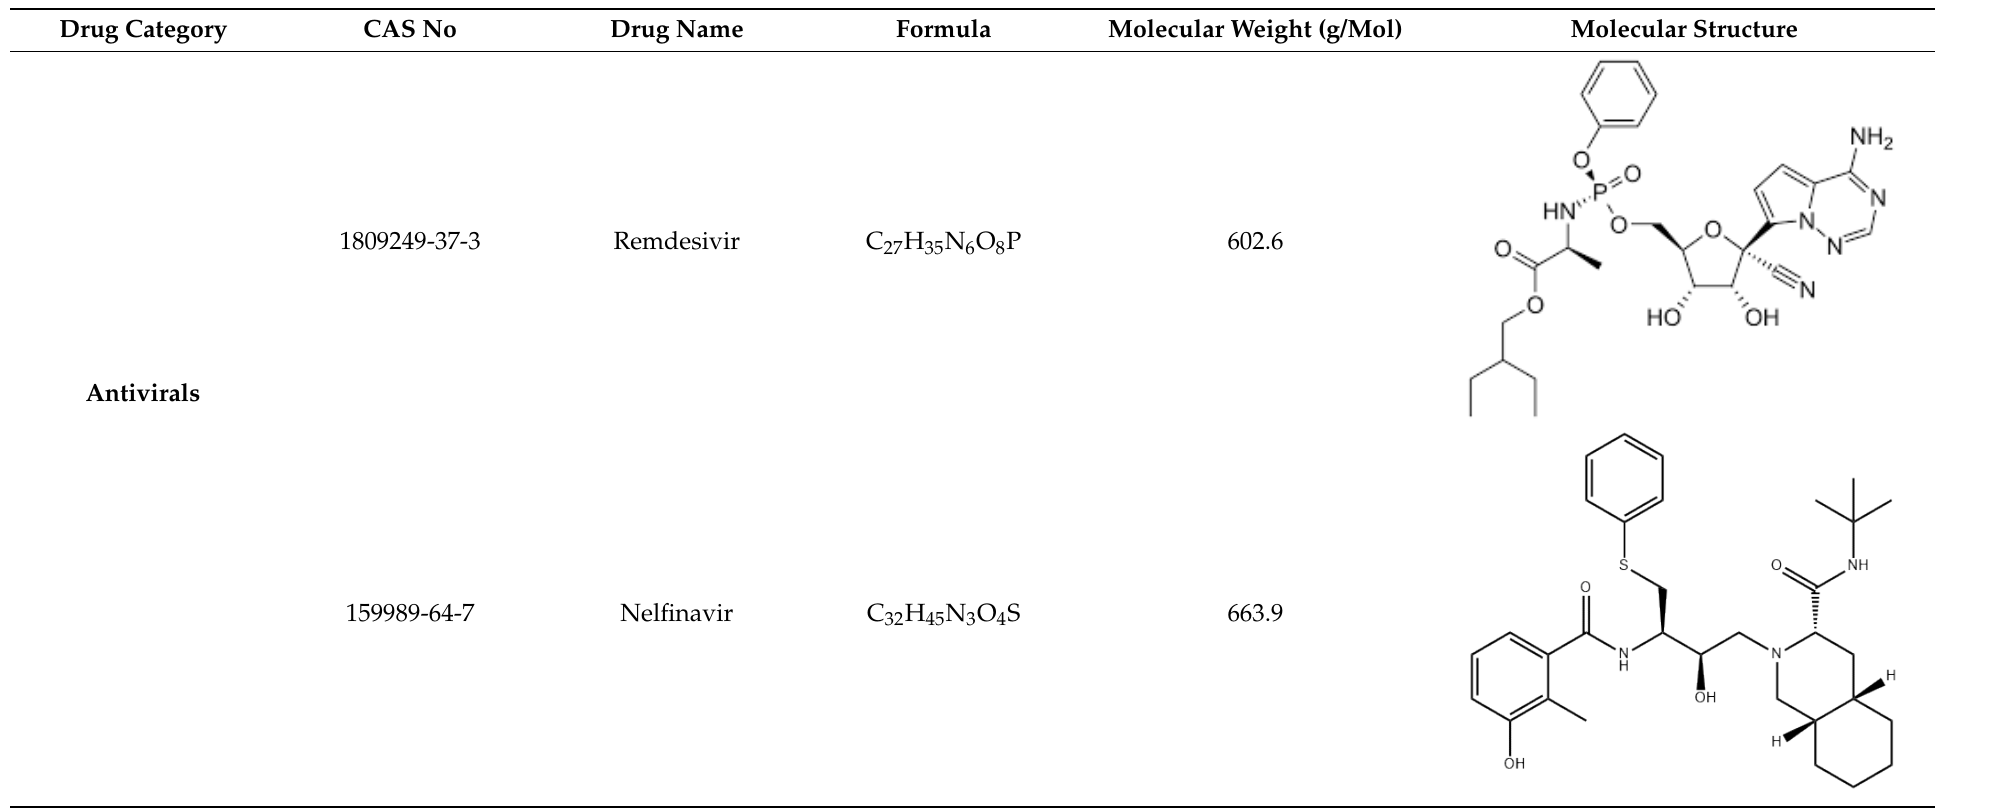
Table 1. Summary of widely used or under trial phase potential candidate drugs for the treatment of COVID-19 patients across the globe.